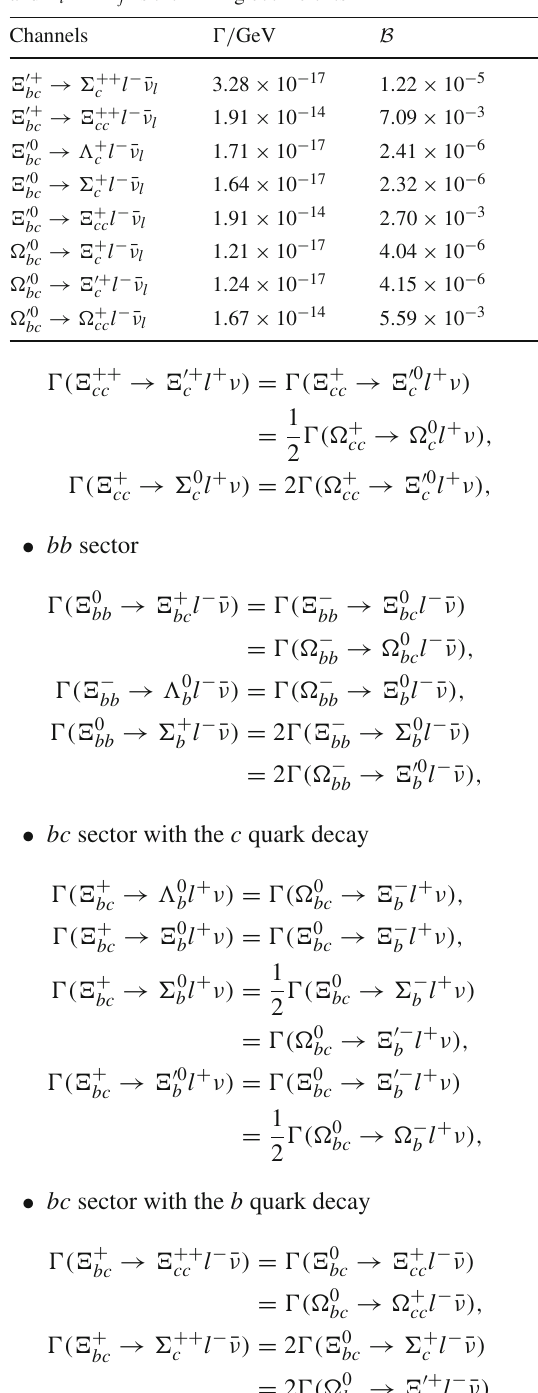
Table 21 The bc sector with the b quark decay and a scalar bc diquark in the initial state: decay widths, branching ratios and the (cid:14) L /(cid:14) T for semileptonic decays, with lepton mass neglected. We have assumed = m τ = τ m B (cid:2) B i and B i , i.e. the only difference between B B (cid:2) i i and